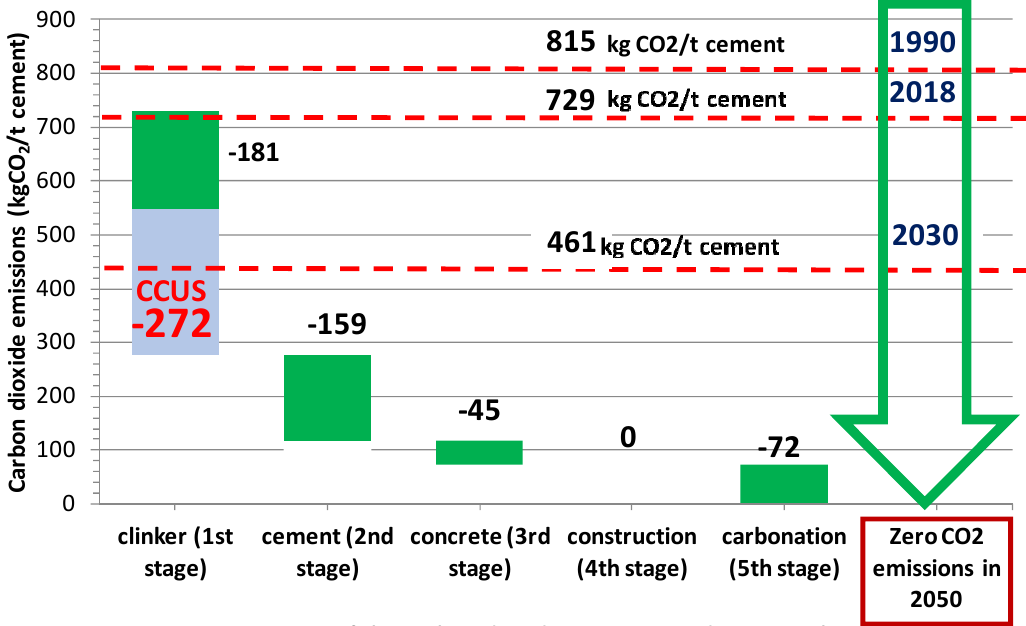
Figure 10. Waterfall chart summarizing the transition from 2018 to 2050 to achieve the carbon neutrality for the Spanish cement industry. These values represent the drop-off in carbon dioxide emissions for each stage considered: clinker, cement, concrete, construction, and carbonation (5Cs).